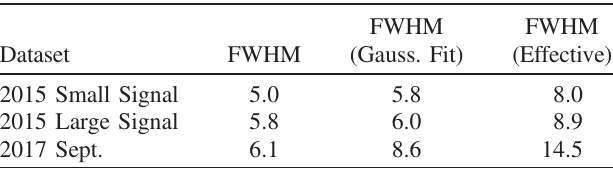
TABLE II. Zero-order PSF widths